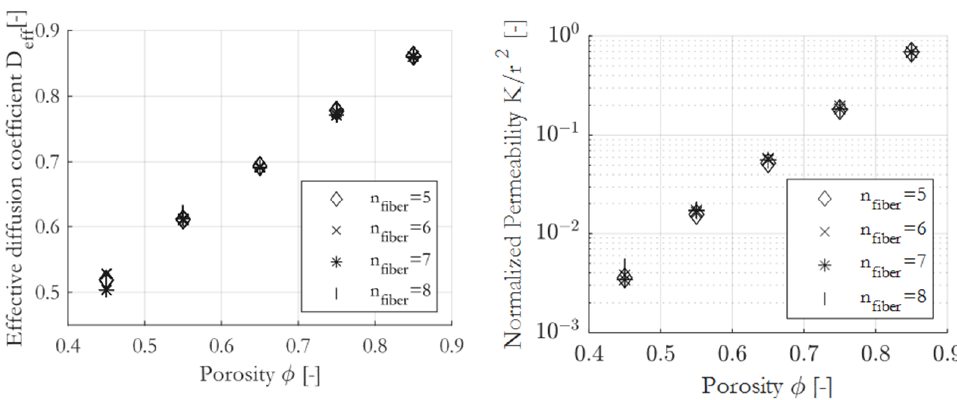
Figure 8. Geometrical mean of transport coefficients, computed for RVEs with a different number of fibers. of